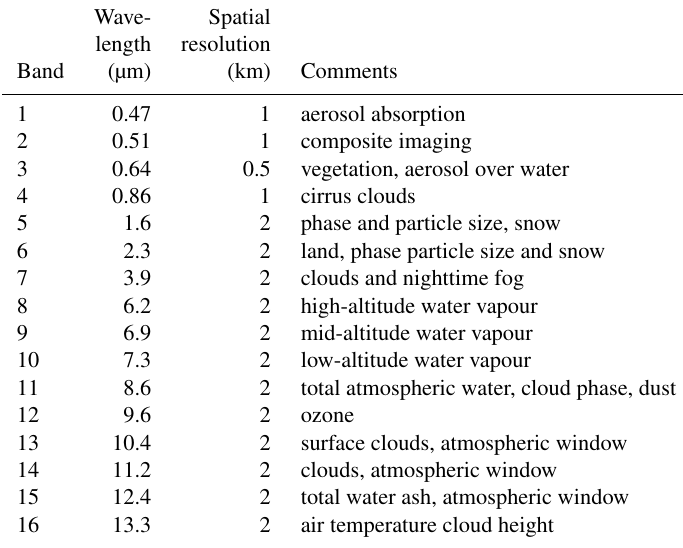
Table 1. Description of Himawari-8 AHI channels (Bessho et al., 2016) and purpose (Zhang et al., 2018). Wave- Spatial length